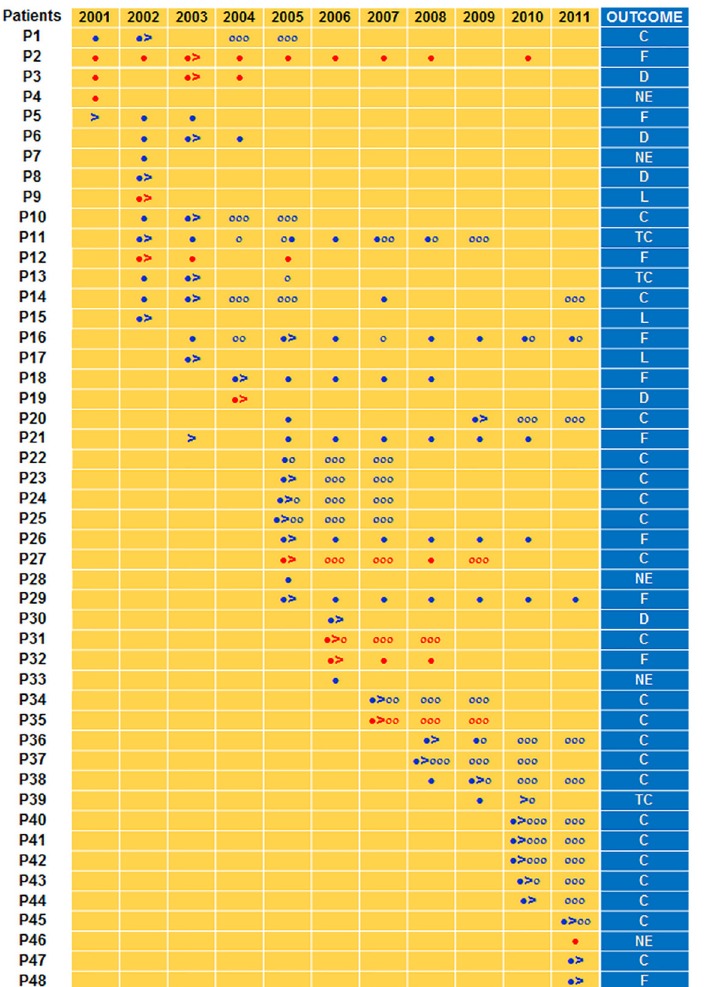
Fig 2. Culture results, time of initiation of second-line chemotherapy, and treatment outcomes for each patient involved in the Haarlem3 MDR-TB outbreak. Red and blue filled circles indicate a positive culture for patients with a 12-banded and 11-banded IS 6110 RFLP outbreak strain, respectively. Red and blue empty circles indicate a negative culture for patients with a 12-banded and 11-banded IS 6110 RFLP outbreak strain, respectively. Time of initiation of second line drugs uptake is indicated by > . Treatment outcomes were based on the WHO definitions and reporting framework for tuberculosis that was revised in 2013 and updated in December 2014 [2]. C: cured; TC: treatment completed; F: failed; D: died; L: lost to follow-up; NE: not